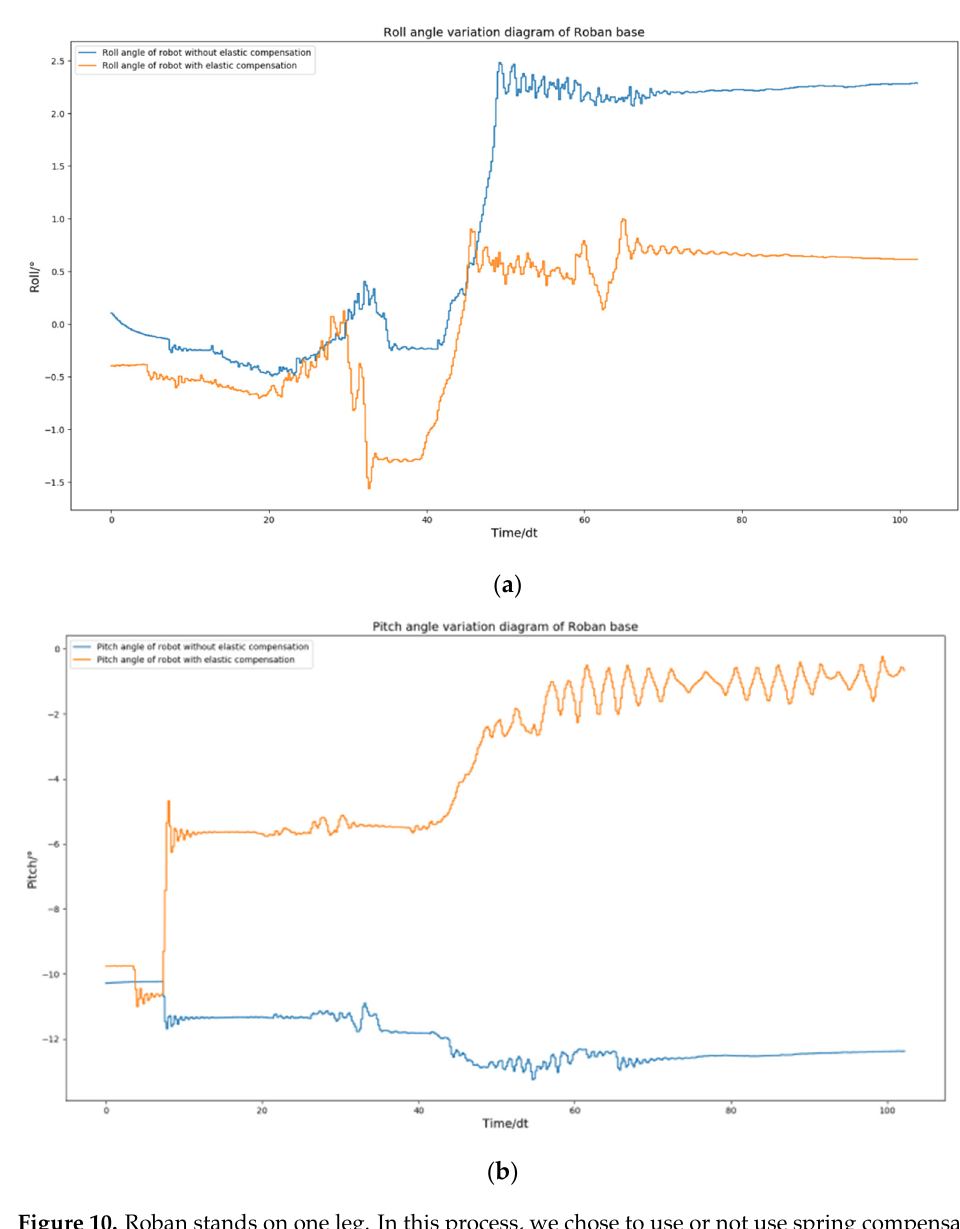
Figure 10. Roban stands on one leg. In this process, we chose to use or not use spring compensation control mode. Figure ( a ) is the comparison of the roll angle of the robot; Figure ( b ) is the comparison of robot pitch angle.